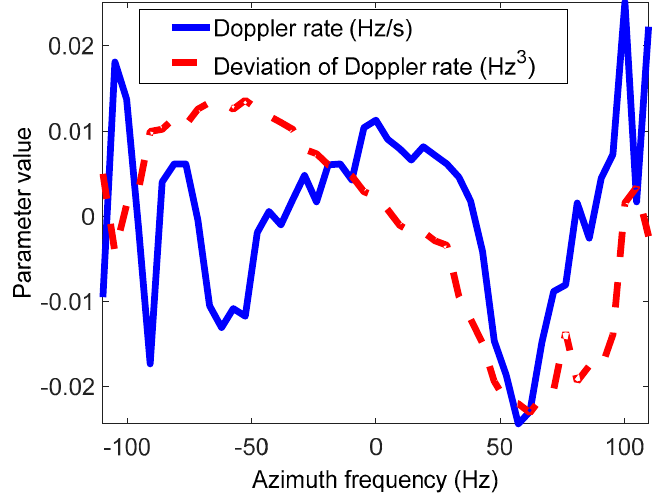
Figure 14. The residual spatial variance of the Doppler parameters after compensation based on the estimation results of the EMAM method.